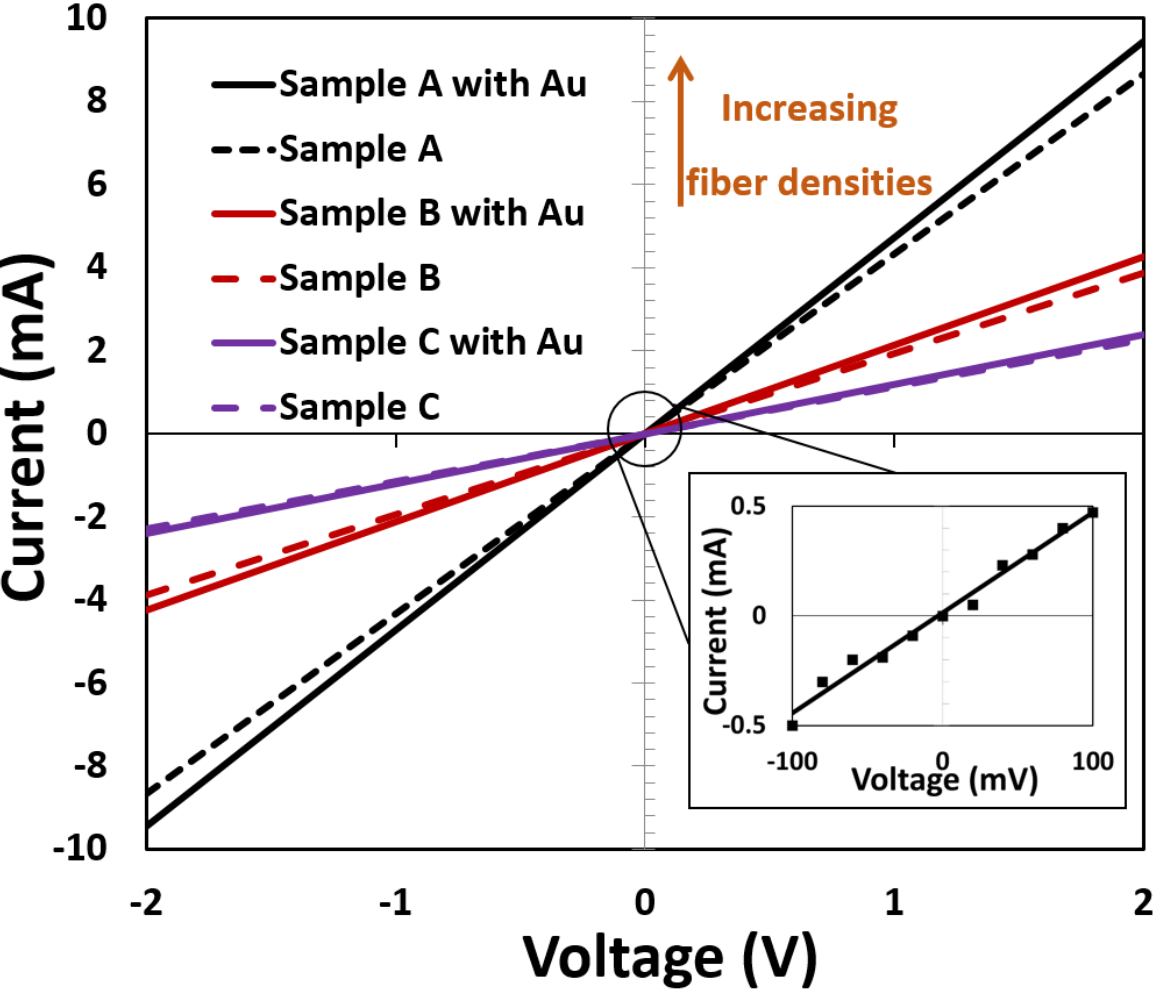
Figure 6. I–V characteristics of different densities of CNF-based sensor with and without Au NPs. The inset shows the I–V characteristic of Sample A with Au from − 100 mV to +100 mV.